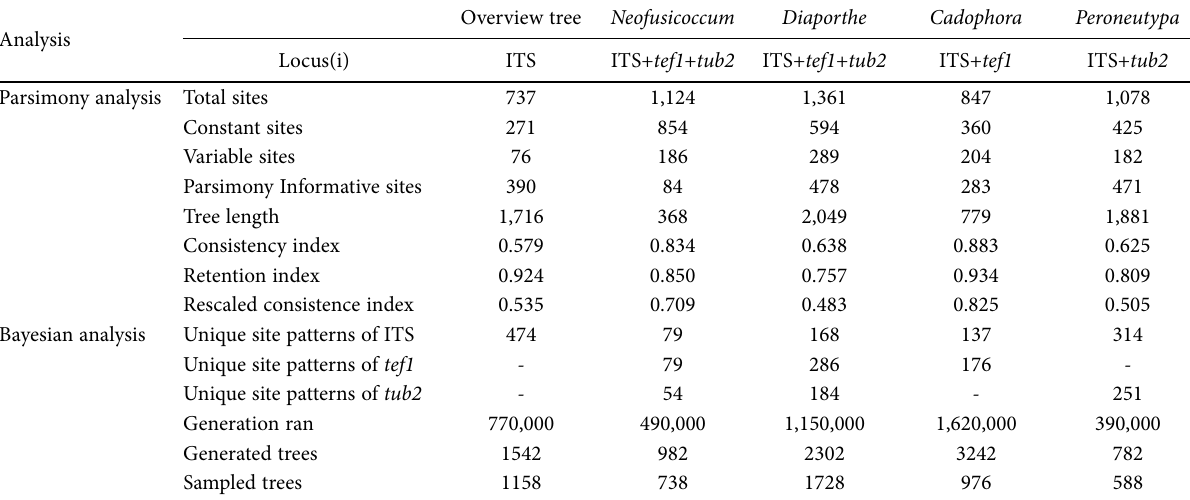
Table 3. Parsimony and Bayesian analyses characteristics in this study.